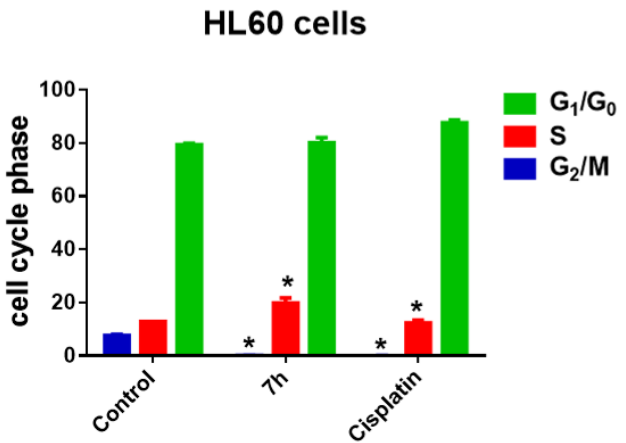
Figure 9. Flow cytometry analysis of the DNA content of HL-60 cells at 48 h of treatment with 7h 25 µM. Quantification of the cells in different phases of cell cycle. Results are represented as average ± SD of two independent experiments. Data were analyzed by t -test, * p < 0.05.